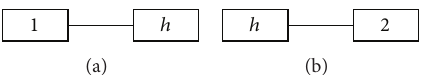
Figure 1: The flow chart of the surge bin system.